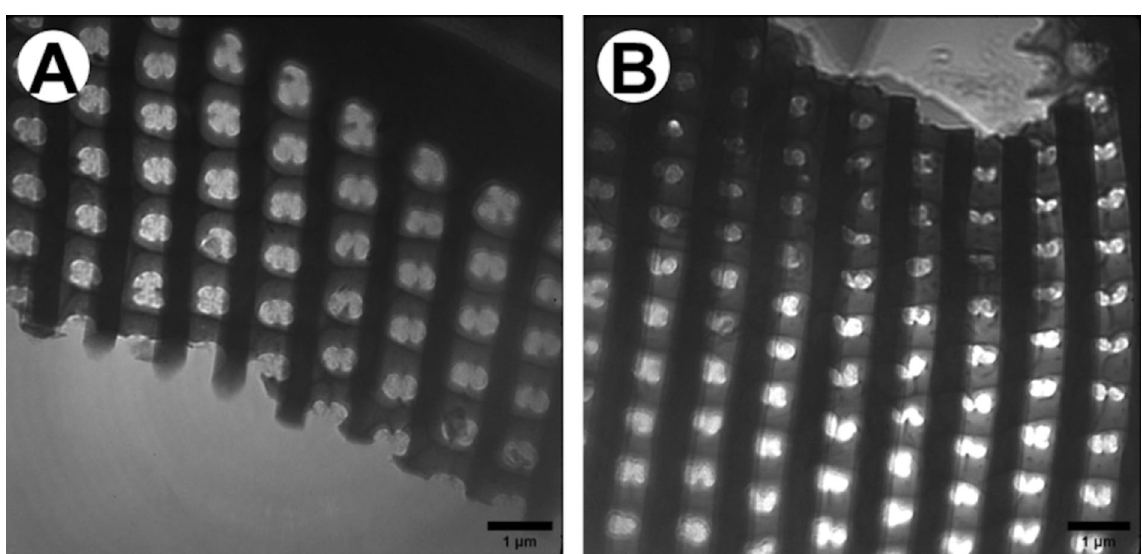
Figure 8. Images of diatoms frustule Coscinodicus sp. obtained by soft X-ray nano tomography investigations.